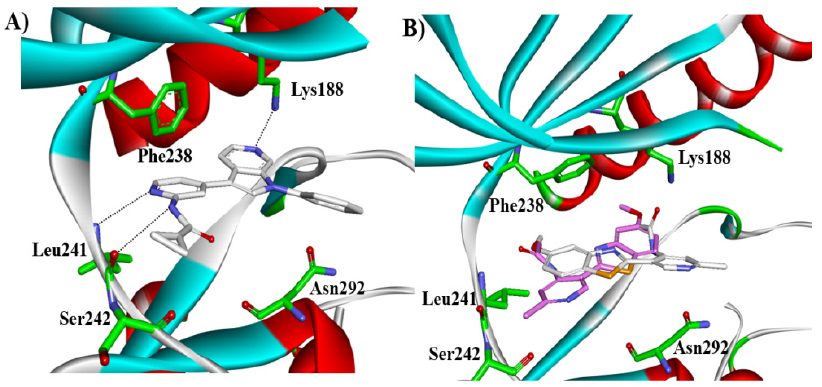
Figure 3. Proposed binding modes of ( A ) compound 73 and ( B ) compound 23 with DYRK1A.